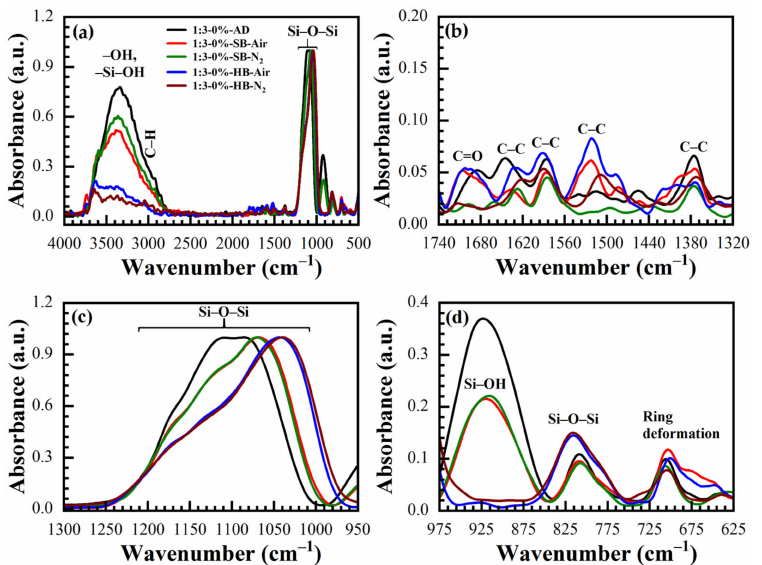
Figure 4. FTIR spectra of benzene-bridged (135TTEB:13BTEB = 1:3 material) organosilicate films without porogen loading, where ( a ) full FTIR spectra; and ( b – d ) are the parts of the full FTIR spectra. The films are as-deposited (AD), soft baked (SB) at 150 ◦ C in the air (SB-Air) and N 2 (SB-N 2 ) for 30 min, hard baked (HB) at 400 ◦ C in the air for 30 min (HB-Air) and in N 2 (HB-N 2 ) for 60 min.